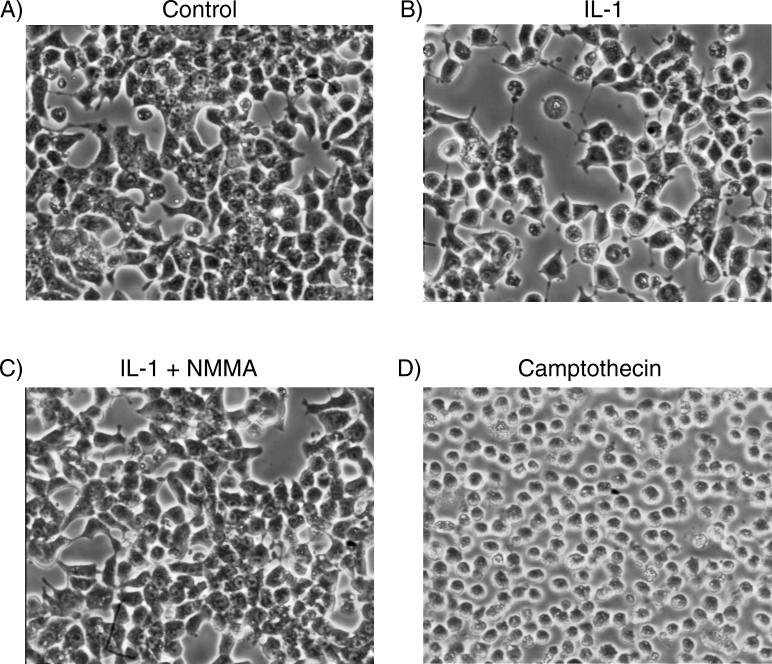
Morphological Analysis of IL-1-Induced RINm5F Cell DeathRINm5F cells were treated for 24 h with IL-1 (10 units/ml) (B and C), NMMA (2 mM) (C), or camptothecin (25 μM) (D), and cellular morphology was examined by phase-contrast microscopy. Treatment with IL-1 resulted in cell swelling and detachment (B), events that are prevented by NMMA (C). In contrast to the effects of IL-1, induction of apoptosis using camptothecin (D) resulted in cell shrinkage and condensation of the nucleus. Untreated control cells are shown in (A). Results are representative of three independent experiments.